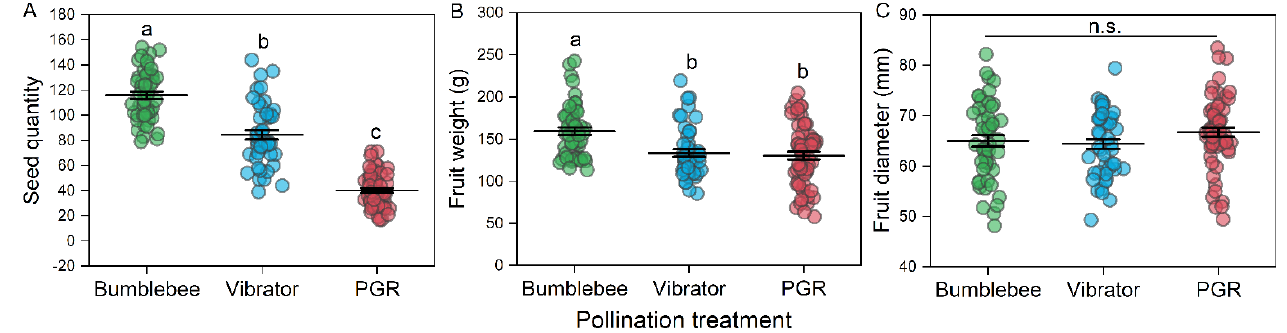
Figure 3. The seed quantity ( A ), fruit weight ( B ), and fruit diameter ( C ) of tomato fruit by different pollination treatments. A total of 157 tomato fruits from three greenhouses were collected and measured. Data are presented as the mean ± 95% confidence interval. General linear models were used to compare the seed quantity, fruit weight, and fruit diameter of tomatoes by different pollination treatments. Different letters indicate significant differences in fruit set based on the Duncan test at α = 0.05.